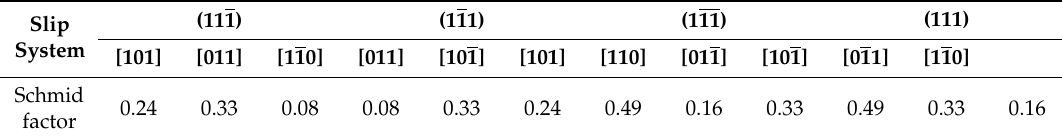
Table 2. Schmid factor of the twelve fcc slip systems for grain A.